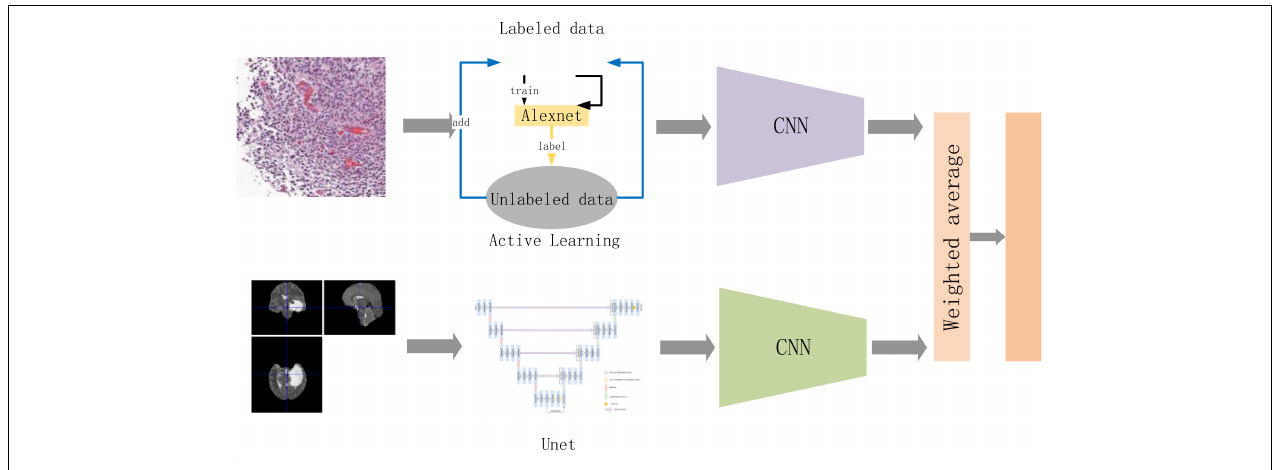
FIGURE 8 | The flow of the entire method. Among them, we slice the entire pathological data and extract the effective diseased area as much as possible. The active learning strategy follows our work in Qi et al. (2018). The goal of that work is to maximize learning accuracy from very limited labeling data. The classification model is updated iteratively with an increasing training set. The sliced pathological data are sent to a convolutional neural network to obtain the discrimination results of the pathological data. The radiological data are sent to the Unet and CNN to obtain classification results after preprocessing. Finally, the results are combined via a weighted average operation to obtain the final result.